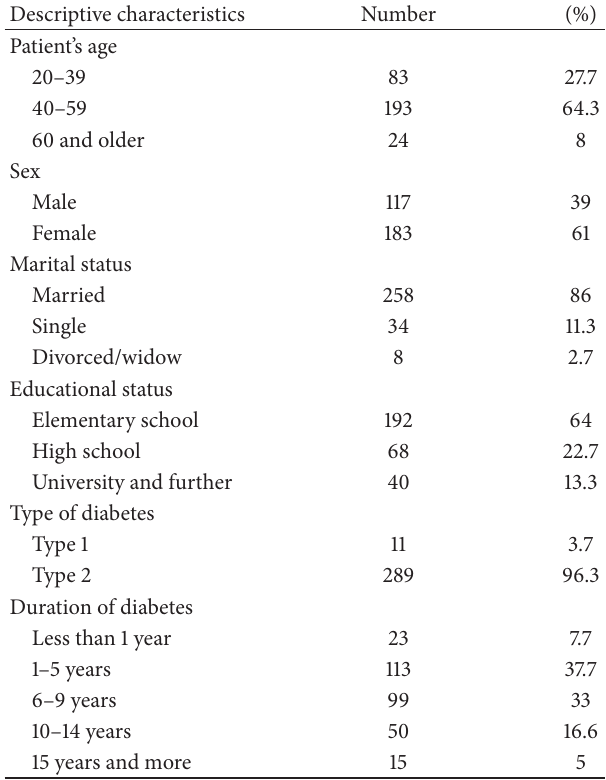
Table 1: Distribution of diabetic patients’ descriptive characteristics ( 𝑛 = 300